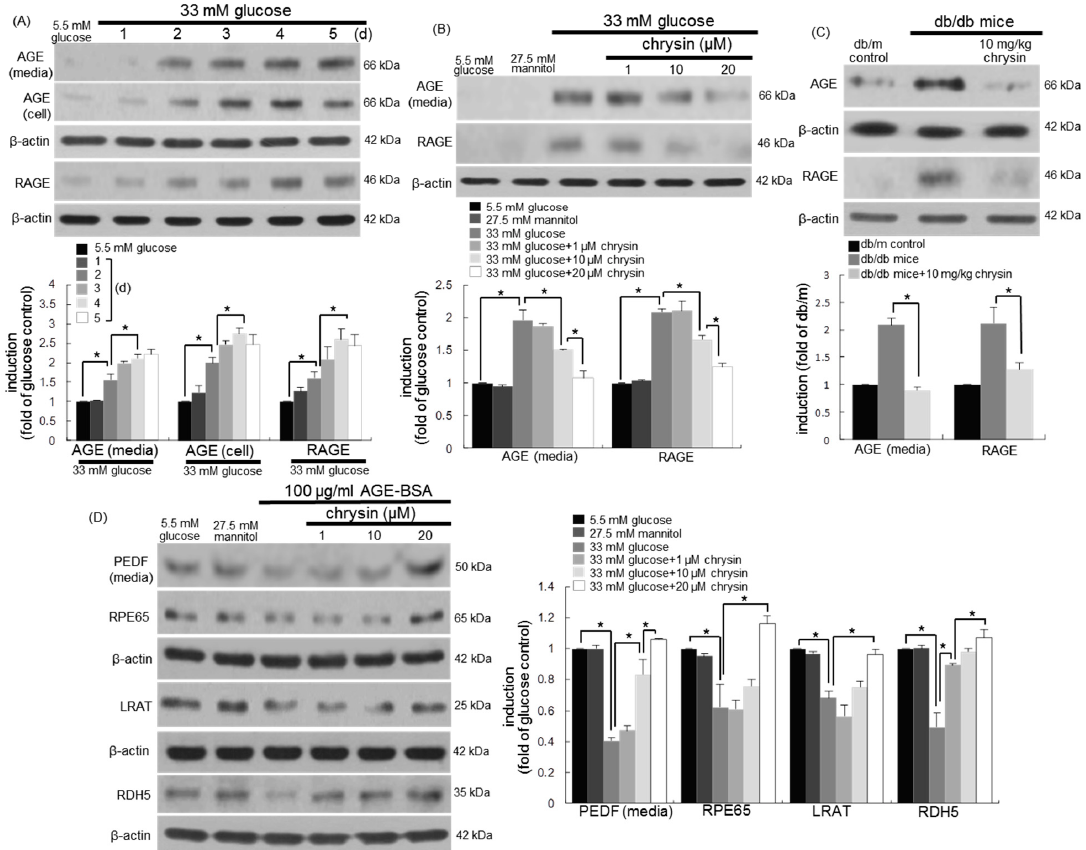
Figure 5. Temporal induction of advanced glycation end products (AGE) and receptor for advanced glycation end product (RAGE) by glucose ( A ), the inhibitory effects of chrysin on their induction ( B , C ), and restoration by chrysin of PEDF and retinal visual cycle enzymes in AGE-BSA-exposed human retinal pigment epithelial (RPE) cells ( D ). RPE cells were incubated with 33 mM of glucose in the absence and presence of 1–20 μ M chrysin for up to five days. Cells were also incubated with 5.5 mM of glucose and 27.5 mM of mannitol as osmotic controls. The db/db mice were orally supplemented with 10 mg/kg of chrysin daily for 10 weeks. The db/m mice were introduced as control animals. Culture media, cell lysates, and mouse retinal tissue extracts were subject to Western blot analysis with a primary antibody against AGEs, RAGE, PEDF, RPE65, lecithin retinol acyltransferase (LRAT), and retinol dehydrogenase 5 (RDH5). β -actin protein was used as an internal control. Bar graphs (mean ± SEM, n = nine independent experiments) in the bottom or right panel represent densitometric results of upper or left blot bands. *, Values in bar graphs indicate a significant difference at p < 0.05.